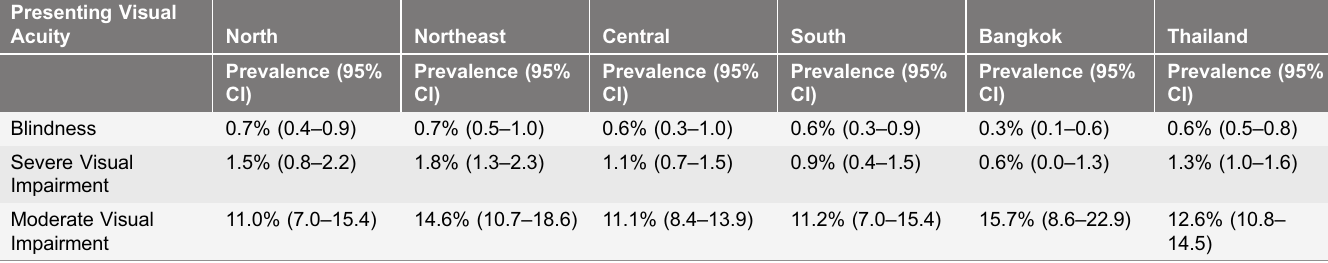
Table 4. Age and Sex Adjusted Prevalence of Blindness, SVI, and MVI in each region of Thailand. Presenting Visual Acuity